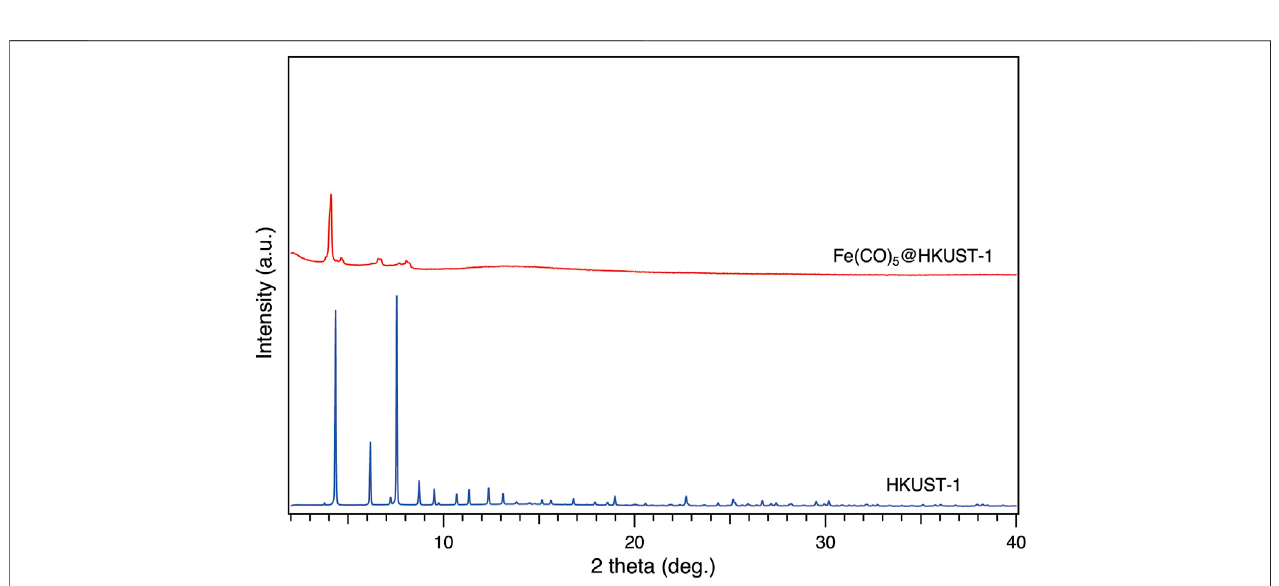
FIGURE 2 | Synchrotron XRPD patterns of activated HKUST-1 (blue) and CVI product of Fe(CO) 5 @HKUST-1 (red) at 303 K. All samples were sealed in glass capillary in a glovebox under Ar atmosphere. The radiation wavelength was 1.000 Å.